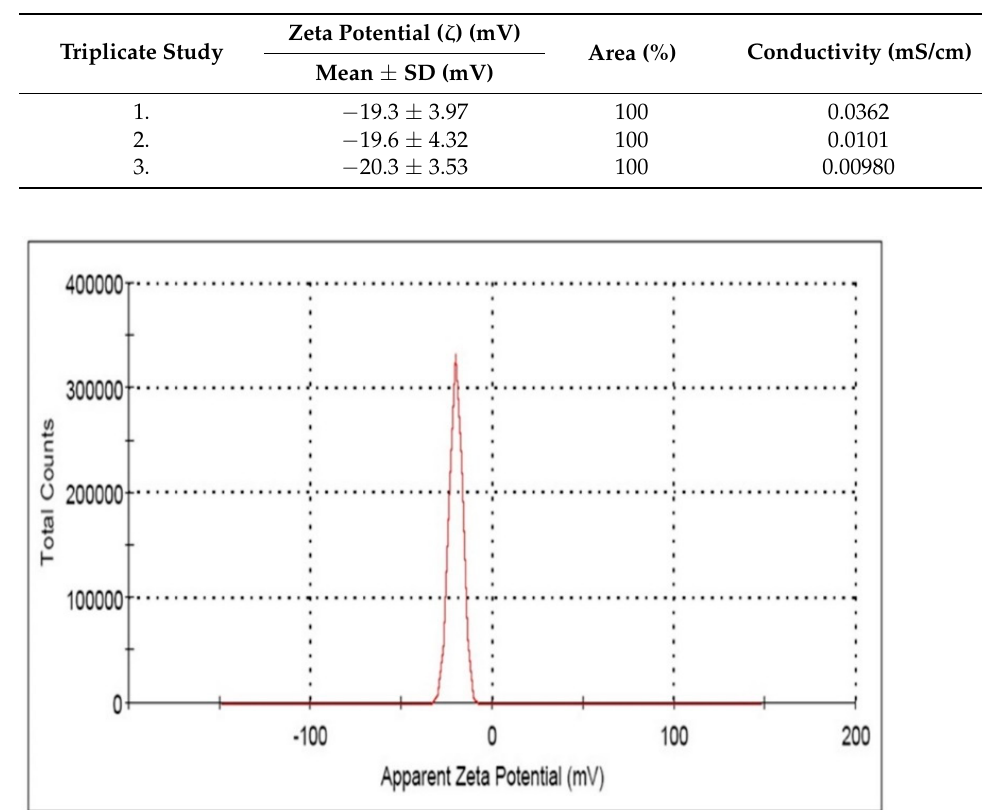
Figure 7. Zeta potential spectrum of Eh-AgNPs. Table 1. Zeta potential value of AgNPs synthesized by E . hormaechei .